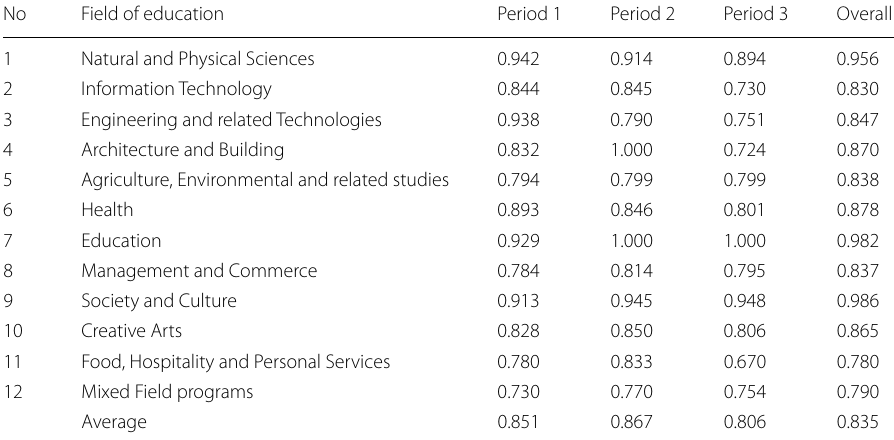
Estimated in a network structure of teaching phase and industry responsiveness